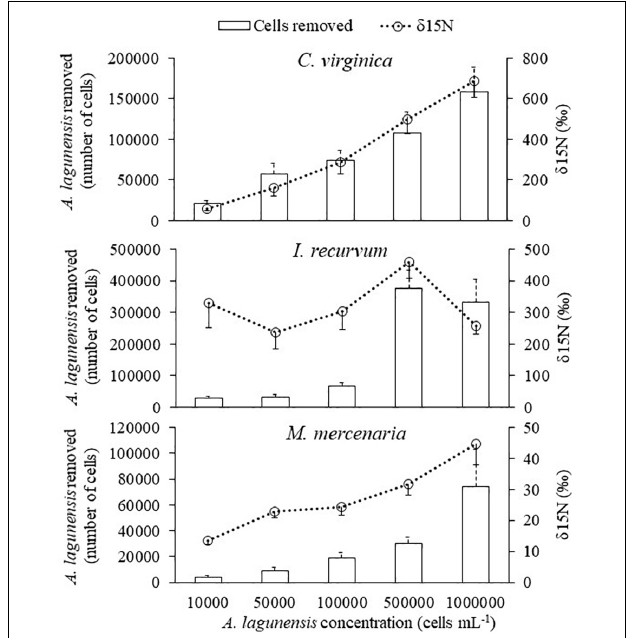
FIGURE 5 | The relationship between the number of Aureoumbra lagunensis cells removed (+SE) by bivalves (bars) and the δ 15 N isotope values (SE) (line) at each algal concentration in one